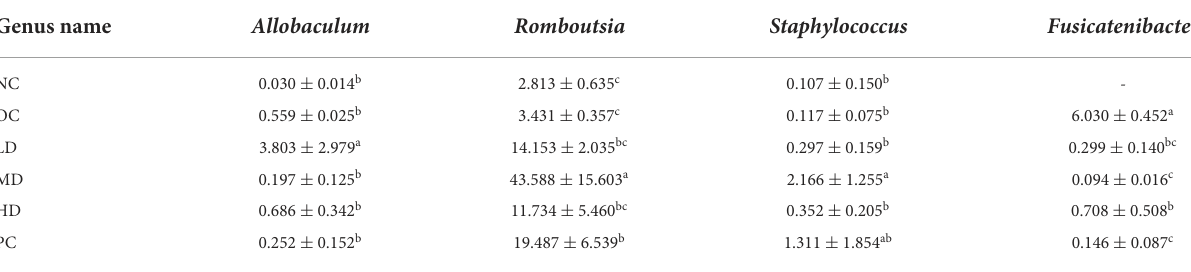
TABLE 4 Effects of plantain on gut bacteria at the genus level.